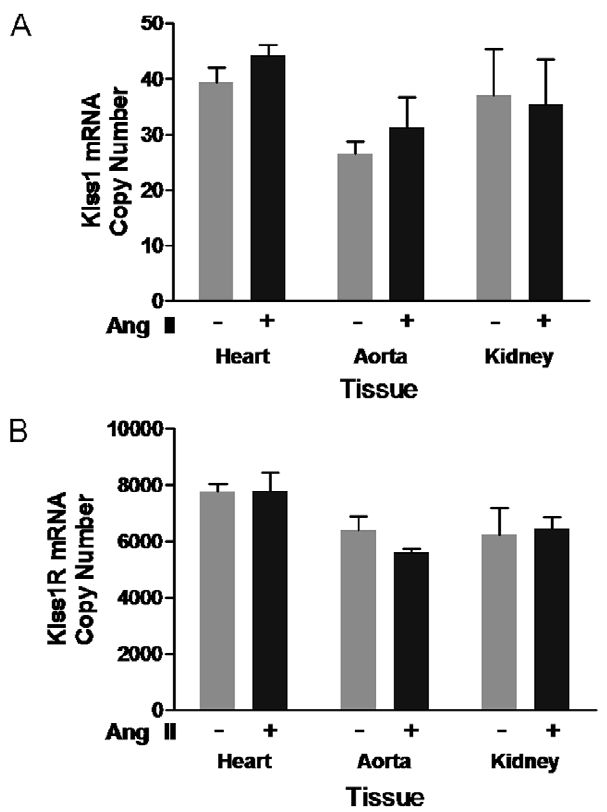
Figure 8. Kisspeptin and Kiss1R expression does not alter after Angiotensin II treatment. C57BL/6 mice were treated with saline (white bars) or angiotensin II (Ang II, black bars) for 14 days. They were then killed and their hearts, kidneys and aortas removed before Kiss1 (A) and Kiss1R (B) mRNA expression analysis. Results are displayed as mean copy number 6 SEM normalised against HPRT-1, SDHA and PLA2 reference genes. N =3 per group. No significant difference was observed between